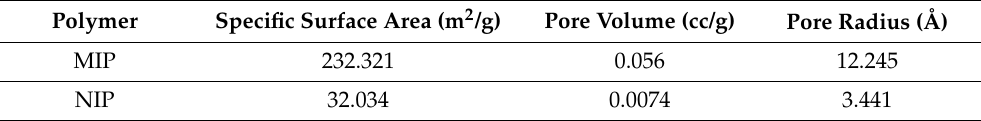
Table 1. BET analysis of MIP.